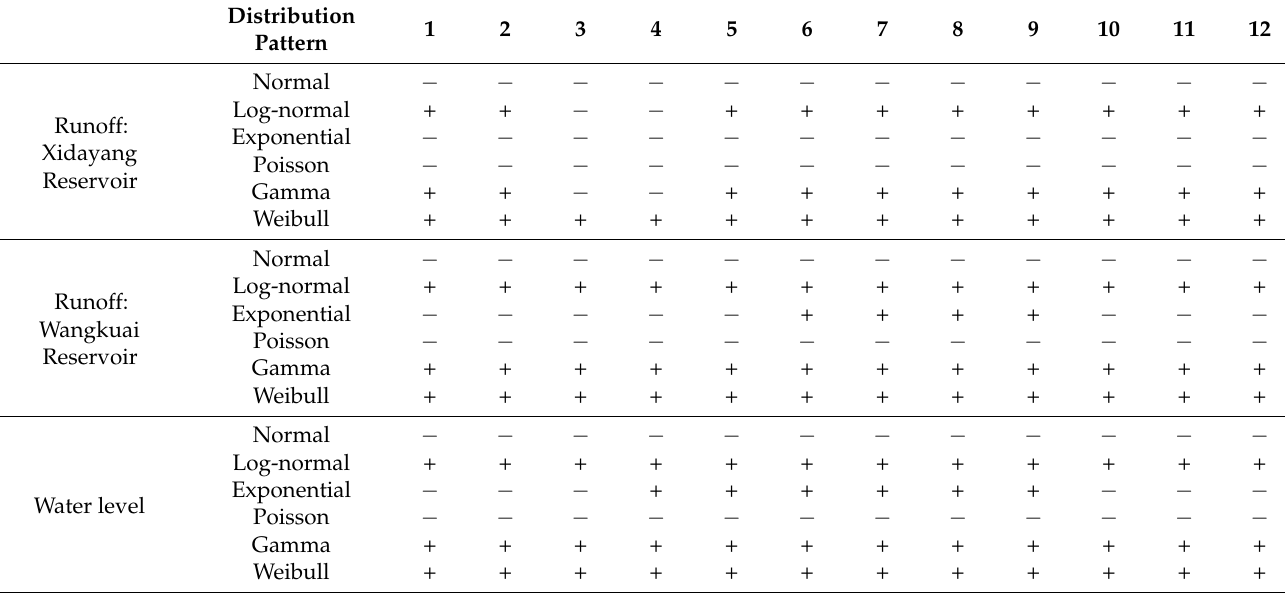
Table 2. The KS test results for the runoff and water level of each month.